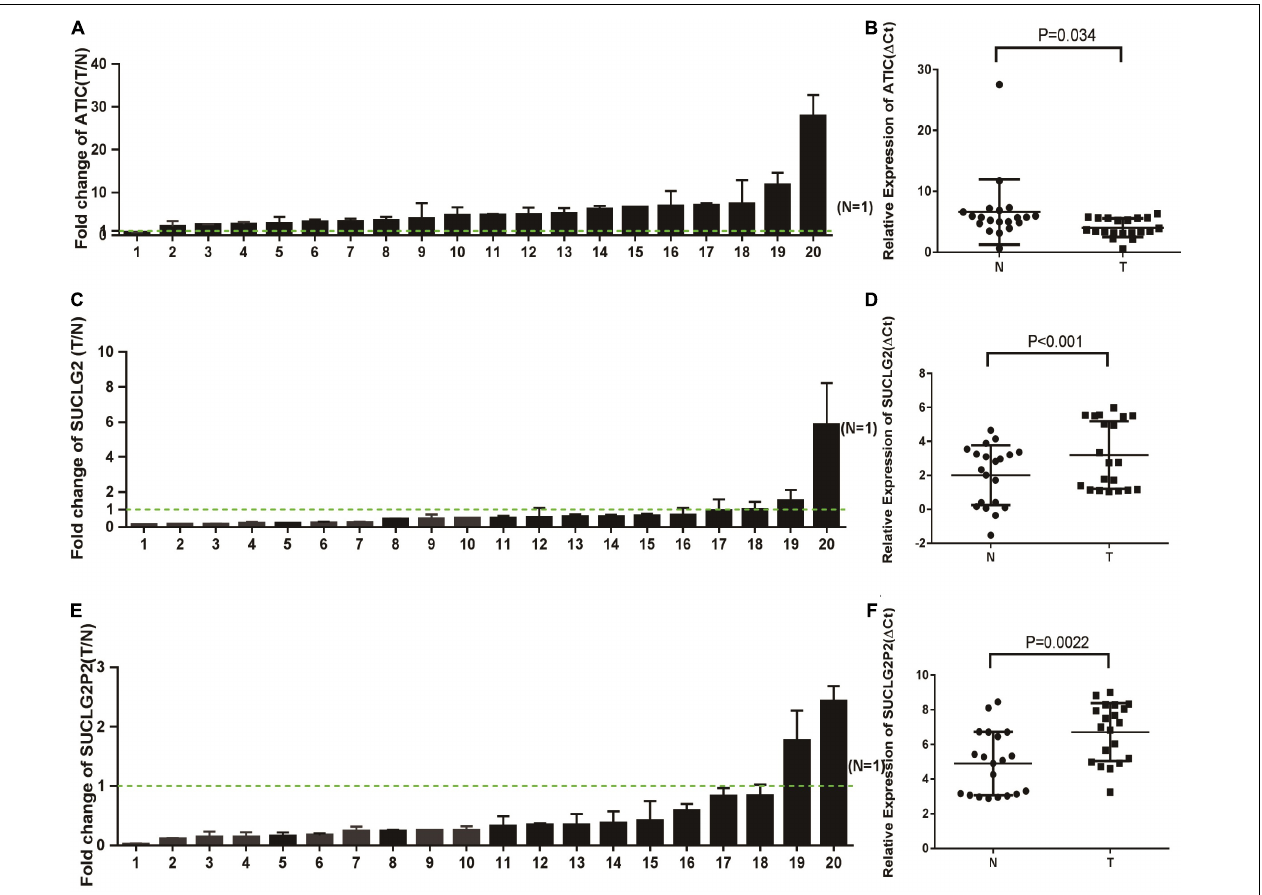
FIGURE 6 | The mRNA expression of SUCLG2P2, SUCLG2 and ATIC in COAD tissues. (A) RT-qPCR analysis of ATIC expression in 20 paired CRC tissues (T) and adjacent normal tissues (N). ATIC expression level was normalized to GAPDH, and the results are presented as the fold change in tumor tissues relative to the matched adjacent normal tissues. Error bars indicate mean ± standard deviation (SD) of three independent experiments. Green dashed line represents T/N = 1. (B) The value of (cid:49) Ct was used to show the expression level of ATIC [ (cid:49) Ct = Ct (ATIC) – Ct (GAPDH)] in the 20 paired human CRC tissues and adjacent normal tissues ( P < 0.01). (C) RT-qPCR analysis of SUCLG2 expression in 20 paired CRC tissues (T) and adjacent normal tissues (N). (D) The value of (cid:49) Ct was used to show the expression level of SUCLG2 [ (cid:49) Ct = Ct (SUCLG2) – Ct (GAPDH)] in the 20 paired human CRC tissues and adjacent normal tissues ( P < 0.001). (E) RT-qPCR analysis of SUCLG2P2 expression in 20 paired CRC tissues (T) and adjacent normal tissues (N). (F) The value of (cid:49) Ct was used to show the expression level of SUCLG2P2 [ (cid:49) Ct = Ct (SUCLG2P2) – Ct (GAPDH)] in the 20 paired human COAD tissues and adjacent normal tissues ( P <